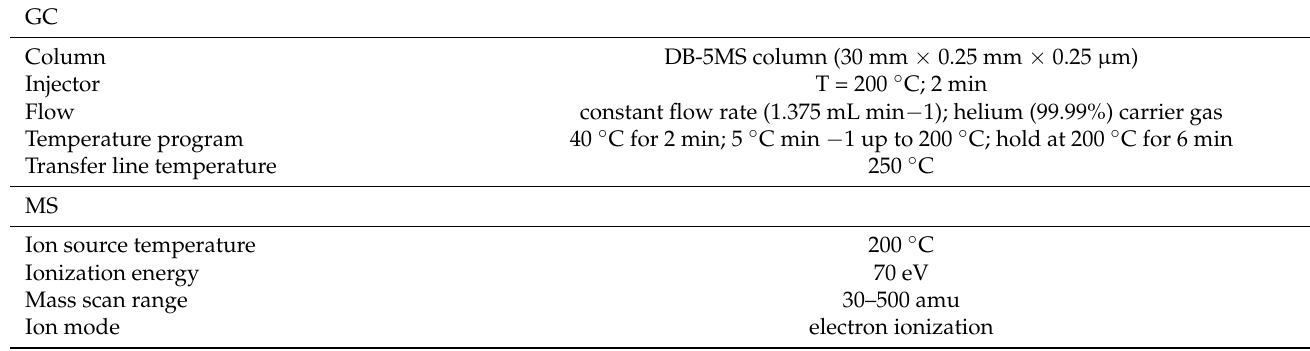
Table 6. Detailed GC-MS conditions.